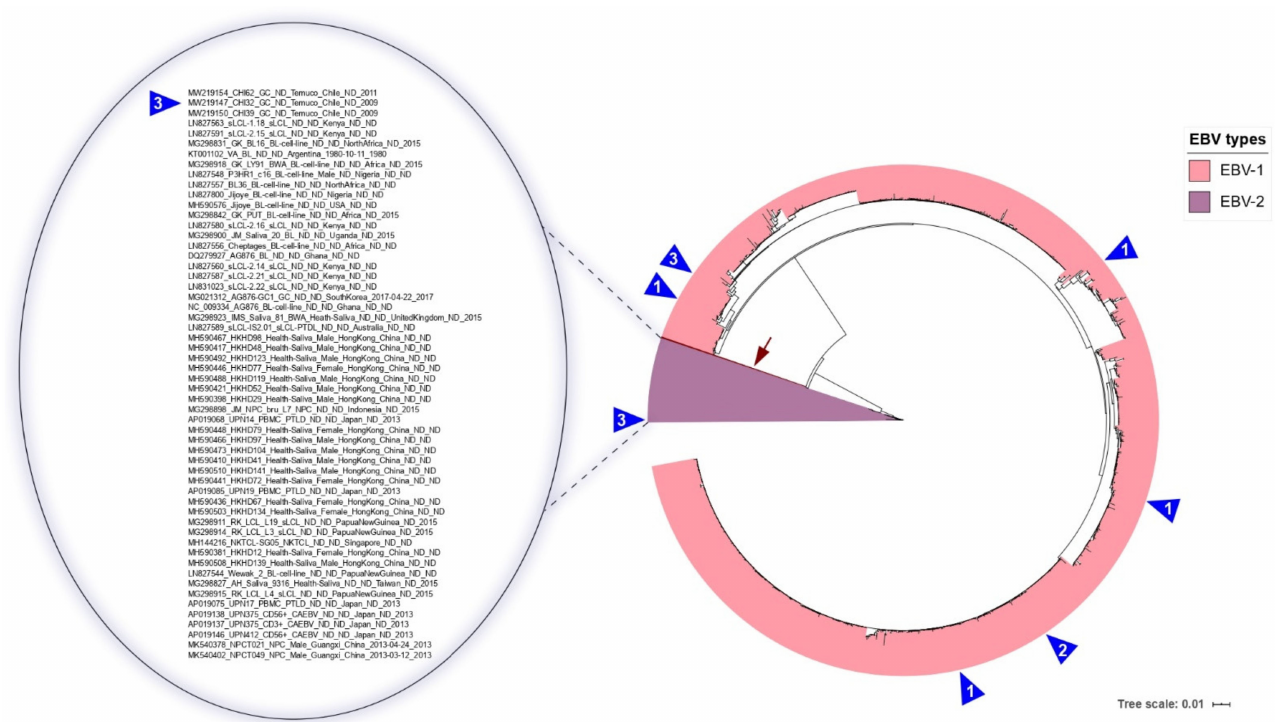
Figure 1. ML phylogenetic tree reconstruction of 1006 EBV EBNA3A sequences (2835 nt) from the 5 continents. In pink are the sequences classified as EBV-1; in lilac are the sequences classified as EBV-2. The two sequences (NPCT021 and NPCT049) closely related to the EBV-2 clade are in burgundy, and are depicted by a burgundy arrow. The zoom area shows in detail the EBV-2 sequences with their associated metadata. Blue triangles represent Chilean sequences identified in this study. The numbers inside the triangle indicate the number of sequences. The scale bar indicates nucleotide substitutions per